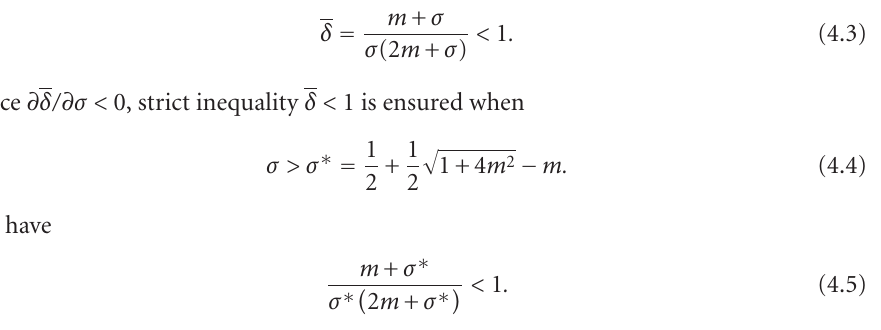
Figure 4.1 depicts the graph of σ ∗ against m . It is worth noticing that ∂σ ∗ /∂m < 0